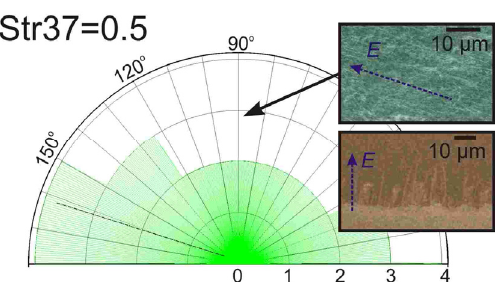
Figure 5. Typical SEM micrographs of an Al PE-CVD reactor (435 V/15 W). E denotes the direction of the electric field. Quantified alignment giving a good mean alignment of Str37 = 0.5. (Scale bar: 10 μ m)